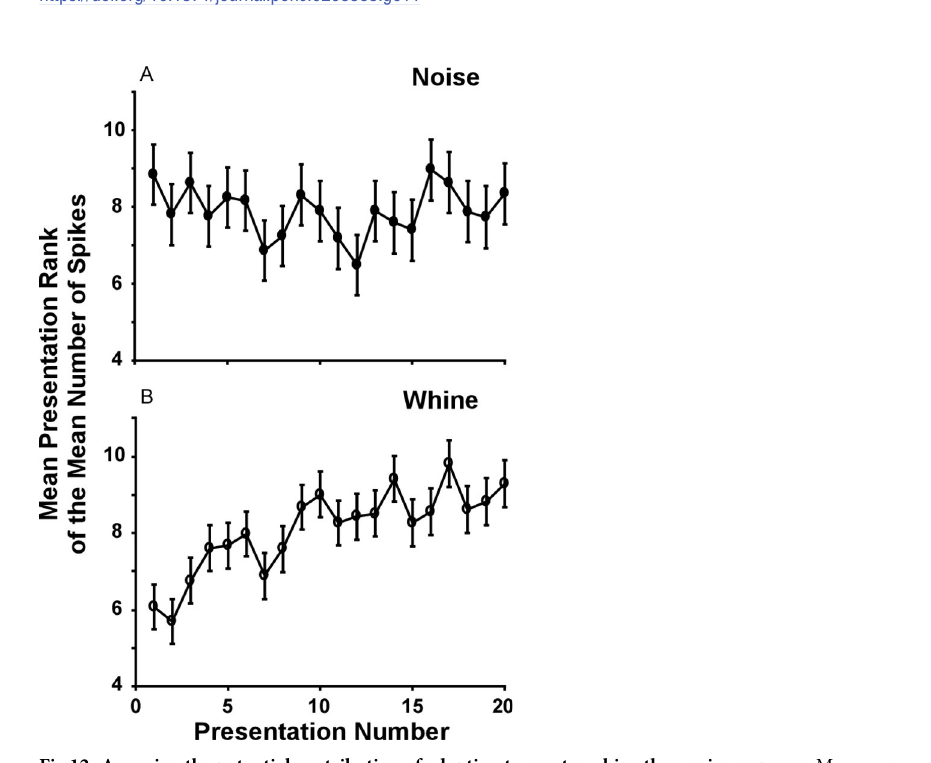
Fig 12. Assessing the potential contribution of adaption to greater whine than noise response. Mean response rank (N = 45 cells) for each of the stimulus presentations. There is evidence for adaption to the whine, but not to noise. Thus, adaptation in this experimental design cannot explain increased excitation to the whine relative to the noise. Note that because the number of action potentials per stimulus was often consistent, response rank included ties, compressing the range of ranks on the